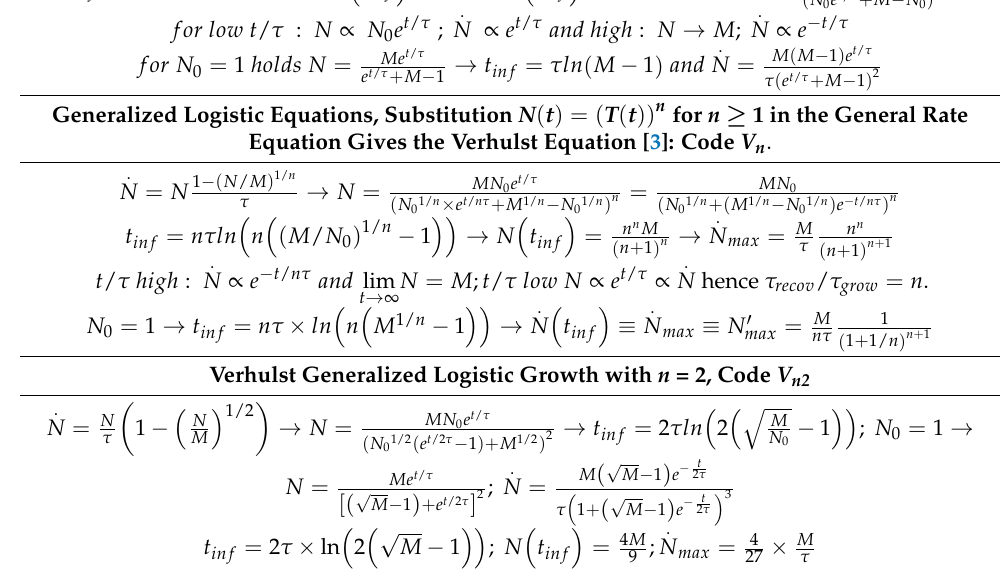
(cid:16) (cid:17) (cid:16) (cid:17) . . t inf N max ≡ N t inf Table 1. Verhulst-type model: M ≥ N ≥ N 0 ; N ; N (cid:48) max ≡ independent of N 0 . Verhulst Limited Growth Model, Logistic Equations ( n = 1): Code V n1 . dN ( t ) ≡ dN ≡ N = 1 − N / M τ dt dt . . for low t / τ : N ∝ N 0 e t / τ ; N ∝ e t / τ and high : N → M ; N ∝ e − t / τ for N 0 = 1 holds N = Generalized Logistic Equations, Substitution N ( t ) = ( T ( t )) n for n ≥ 1 in the General Rate Equation Gives the Verhulst Equation [3]: Code V n .